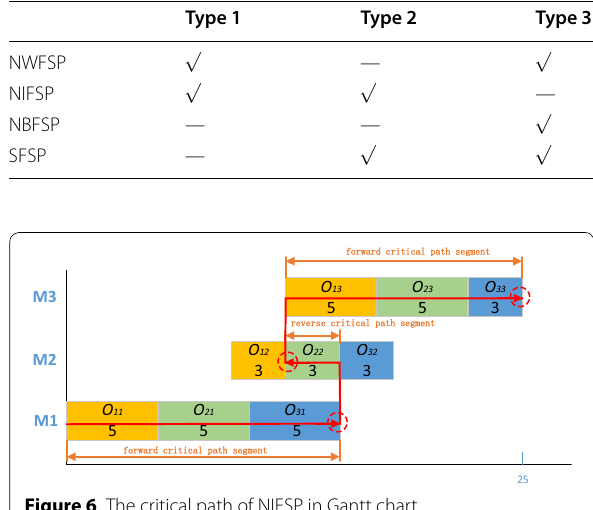
Figure 6 The critical path of NIFSP in Gantt